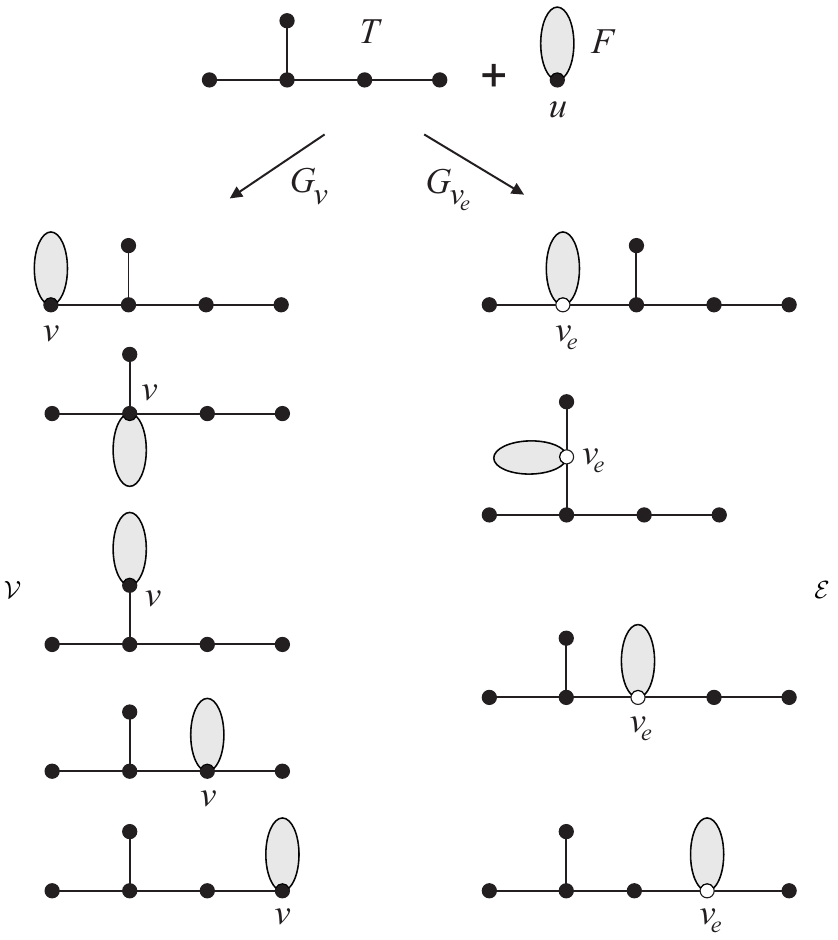
Figure 1: Families V and E of graphs obtained by joining a tree T and a graph F